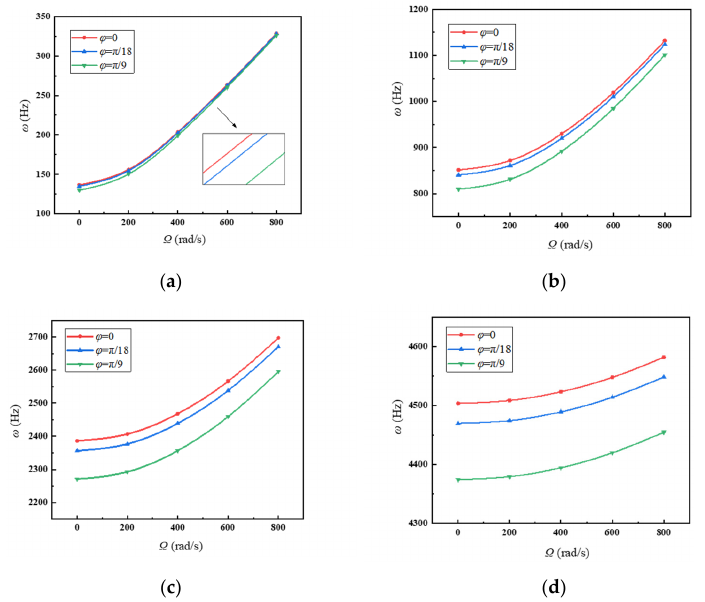
Figure 13. Variations of frequencies with rotating speed under different pre-twist angles. ( a ) First frequency; ( b ) second frequency; ( c ) third frequency; ( d ) fourth frequency.